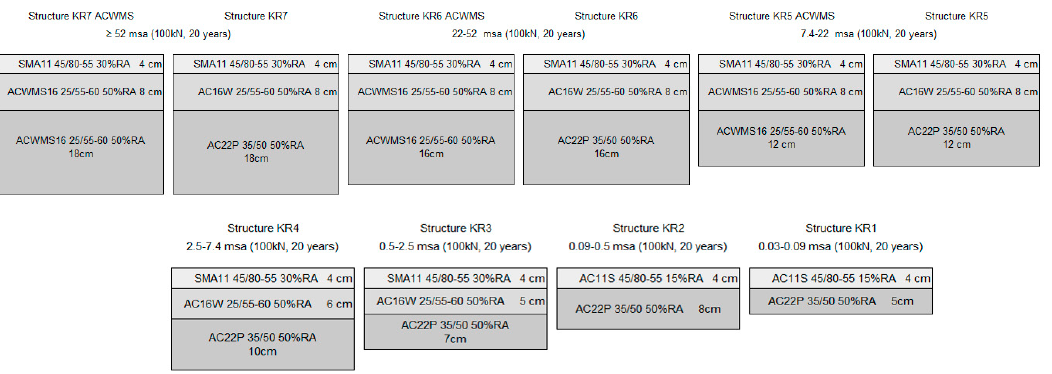
Figure 7. Upper layers of pavement structures for fatigue analyses for different traffic load categories.